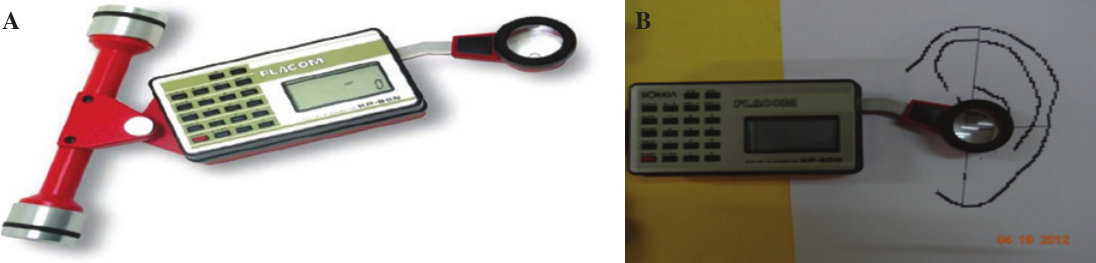
Figure 7: Calibration of Computed Area. (A) Digital Planimeter. (B) Area Measurements Using the Digital